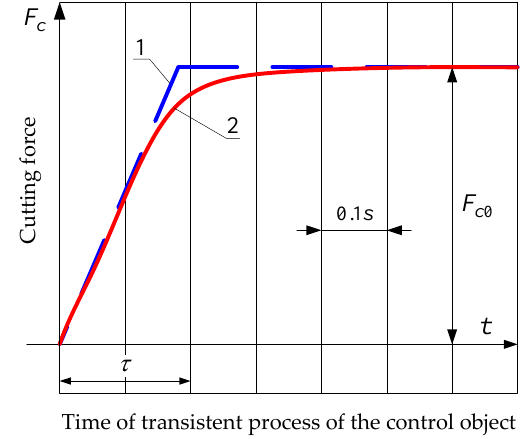
Figure 8. Experimental transient curve of the control object. 261